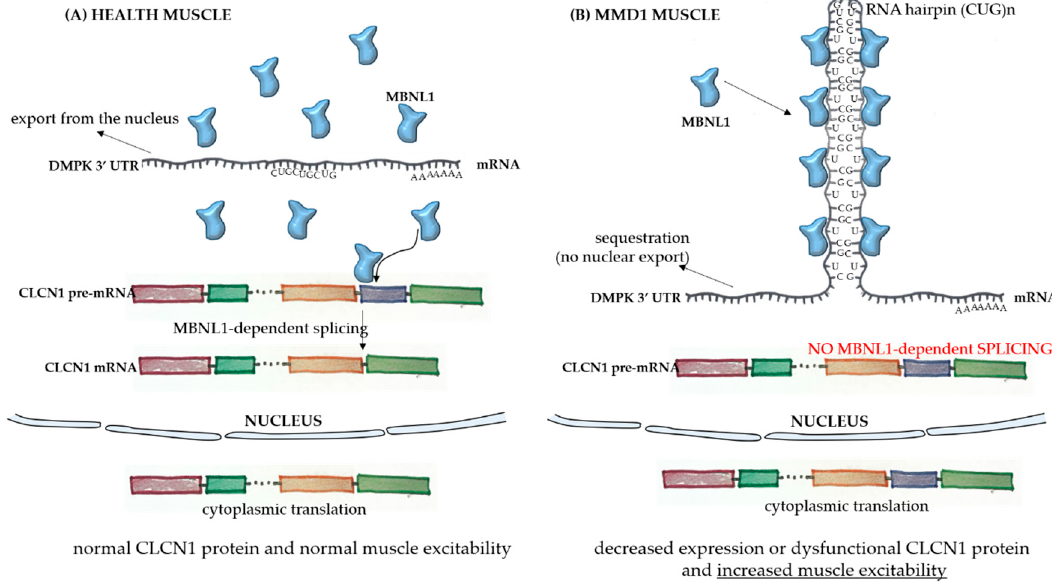
Figure 1. Pathophysiology of myotonic muscular dystrophy type 1. In healthy skeletal muscle